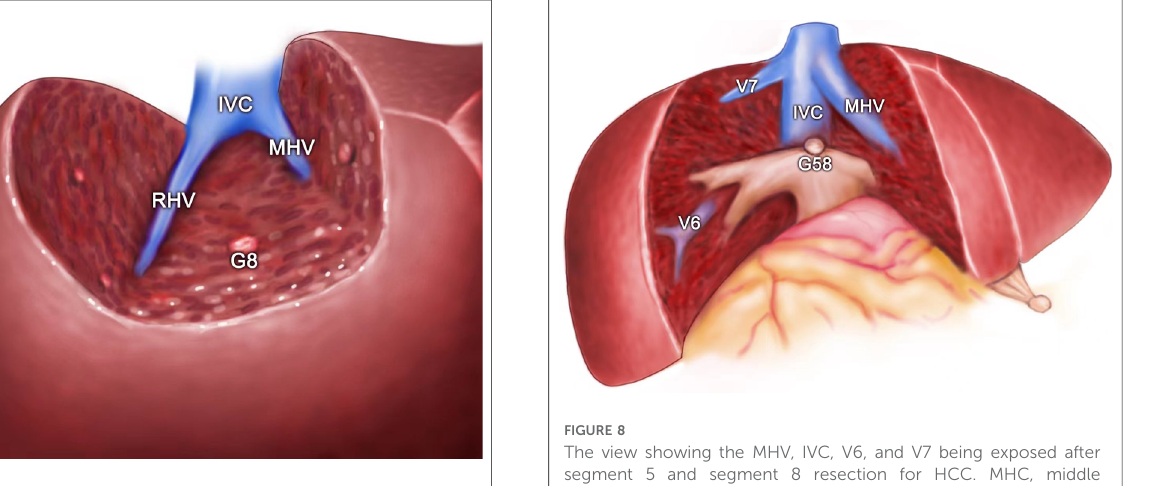
FIGURE 6 The view showing the MHV, RHV, and IVC being exposed after segment 8 resection guided by the inserted needle. MHC, middle hepatic vein; RHV, right hepatic vein; IVC, inferior vena cava; G8, Glisson ’ s 8.